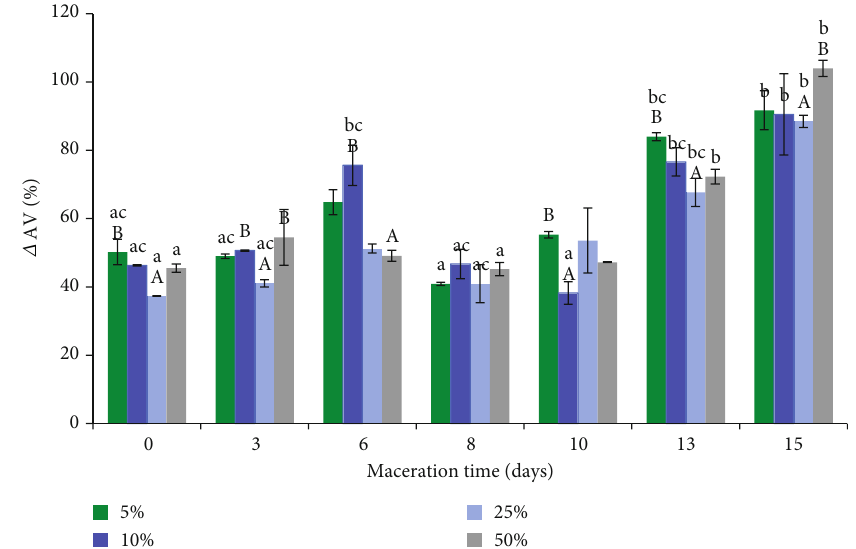
Figure 3: The e ff ect of the addition of di ff erent concentrations of sage macerate (5%M-50%M), applied after a di ff erent day of maceration, on CLO quality parameters, expressed as delta ( Δ ) of anisidine value (AV), in the UV test (Values marked with the same lowercase letter a, ac, … , do not di ff er statistically signi fi cantly ( p < 0 : 05 ) within each macerate concentration, while the values marked with the same uppercase letter — A, AC — do not di ff er statistically signi fi cantly ( p < 0 : 05 ) on individual maceration